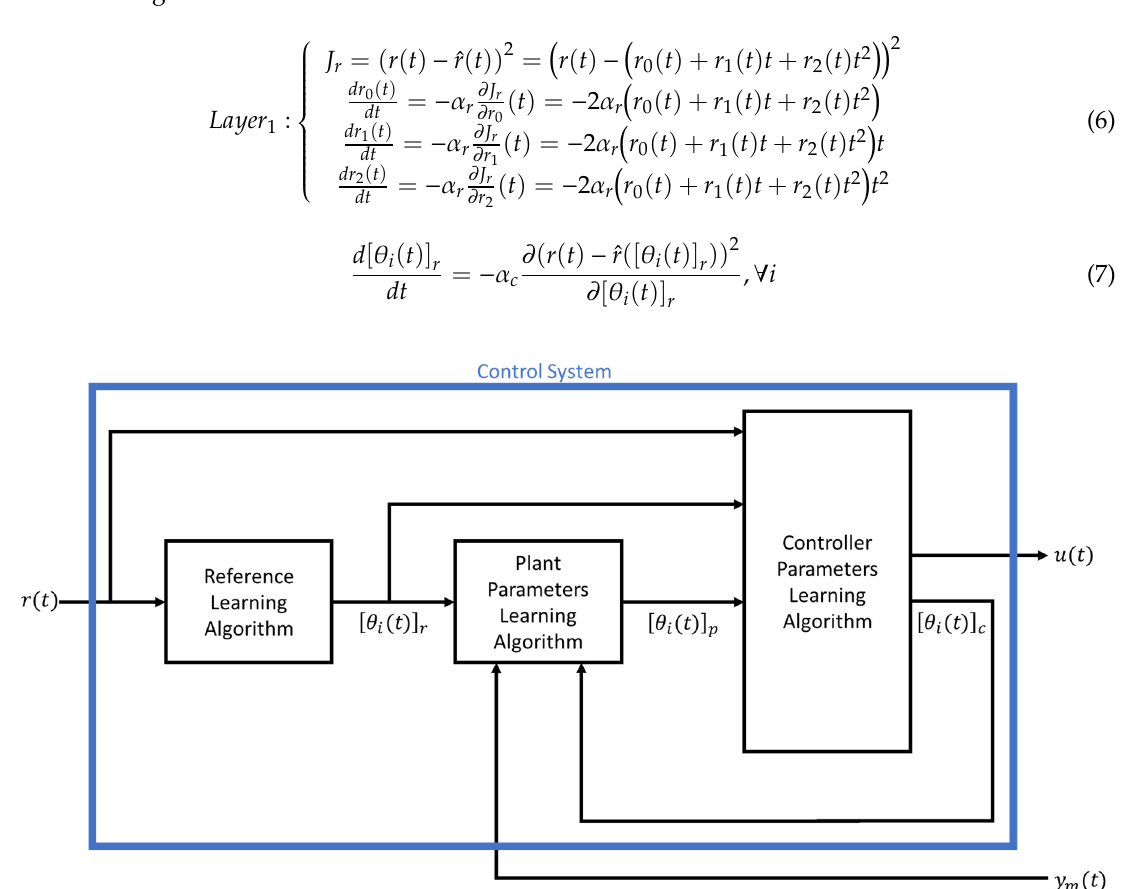
Figure 4. Schematic representation of the internal architecture of proposed control system.